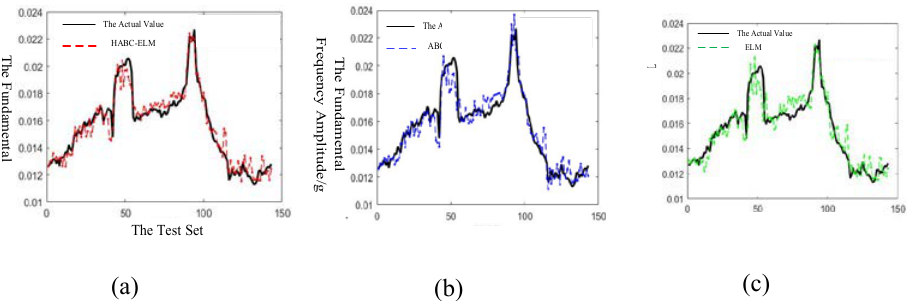
Fig.7. Comparison of prediction results of each models (low voltage phase a).